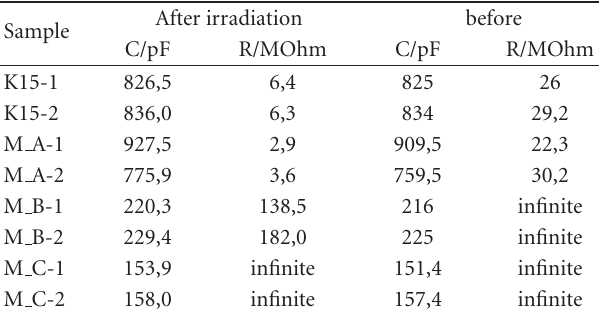
Table 2: Capacitance and conductivity values before and after proton